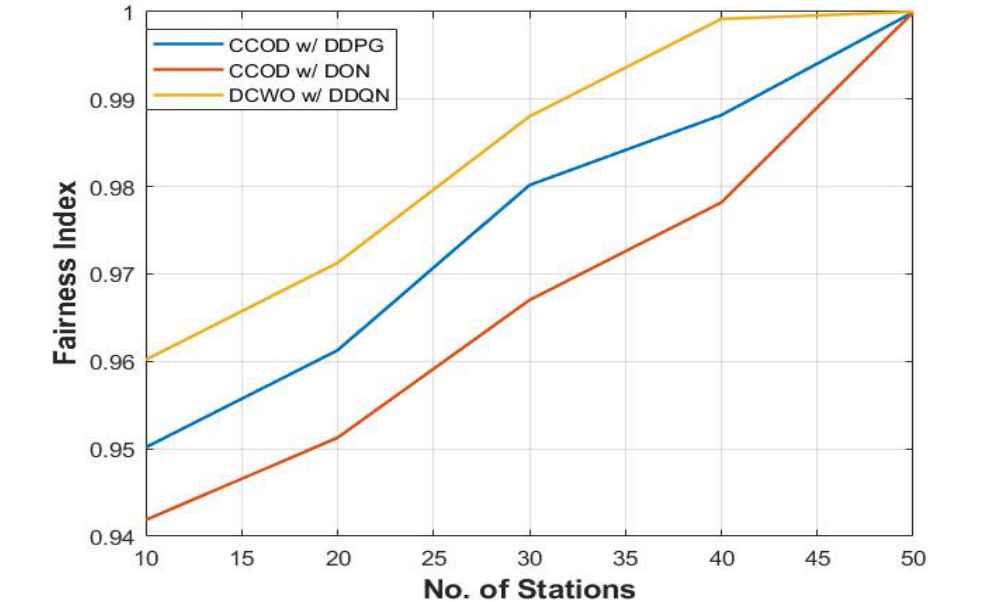
Figure 9. Network Fairness Index for Static